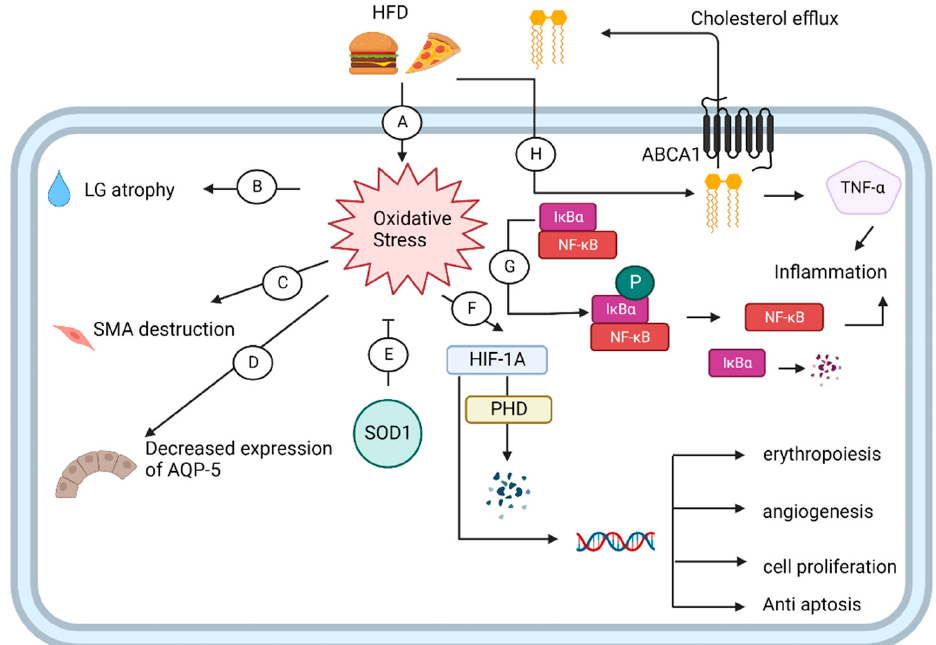
Figure 8. Underlying mechanisms of PSP treatment in ameliorating HFD-induced DED. A, HFD is highly related to accumulation of intracellular oxidative stress, which was a crucial contributing factor toward DED [9,59]. B, Accumulation of oxidative stress leads to LGs atrophy [31], and LGs atrophy area in HFD-fed rats is significantly larger than those of PSP-fed rats. C, Oxidative stress may decrease SMA expression in LGs [60], and α -SMA is lower in HFD-fed rats compared with those with PSP supplement. D, Decrease in AQP-5 mRNA has been found in DED [28]. LGs of HFD-fed rats have lower AQP-5 expression level than that of PSP treatment. E, SOD-1 is preserved more in LGs of PSP-treated rats than that of HFD-fed rats, implying that PSP treatment reduces oxidative stress. F, PSP treatment reduces HIF-1 α levels of LGs. G, PSP treatment increases I κ B α levels to suppress inflammation. H, PSP treatment increases ABCA1